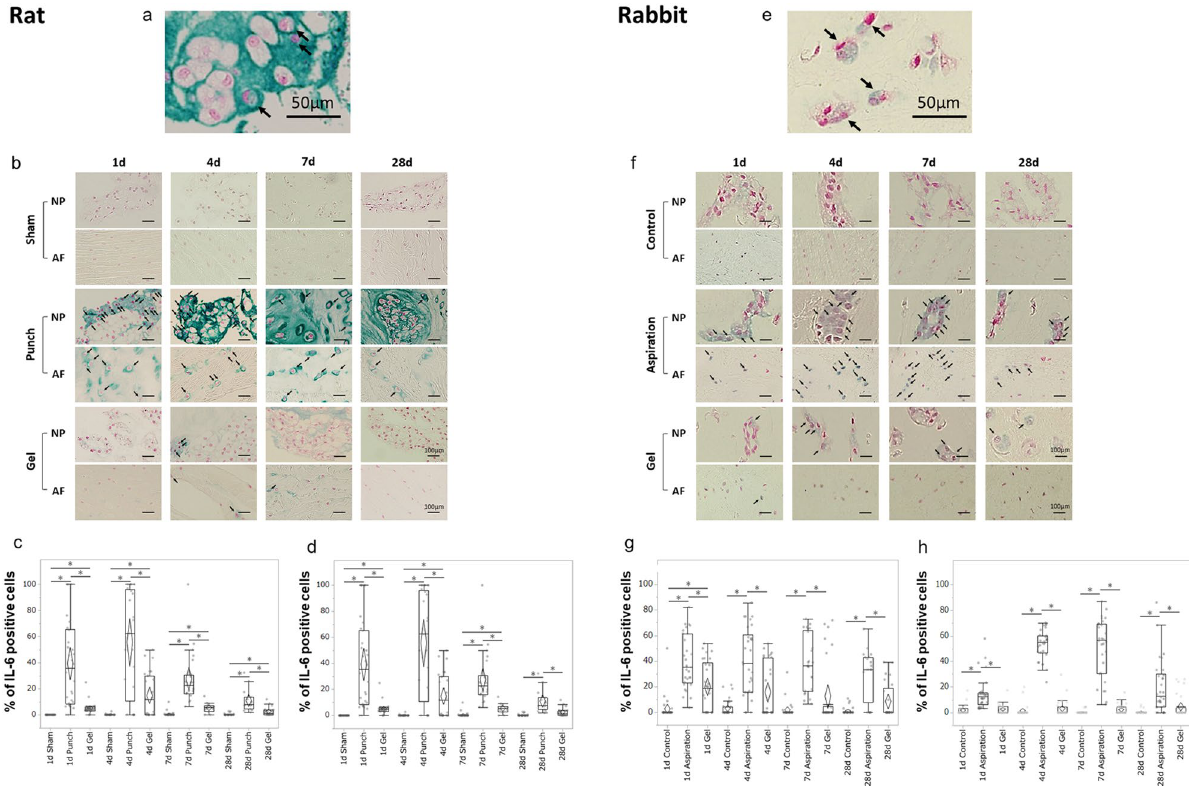
Figure 3. UPAL gel inhibits interleukin-6 (IL-6) production in rat and rabbit intervertebral disc (IVD) degeneration models. The rat nucleus pulposus (NP) punch ( a – d ) and rabbit NP aspiration ( e – h ) models were used for immunohistochemical (IHC) analysis to detect the IL-6 levels 1, 4, 7, and 28 days after surgery. The number of IL-6-positive cells in each staining was calculated as a percentage of the number of total NP or annulus fibrosus (AF) cells in five independent, randomly selected fields per disc. IL-6-positive cells are stained green, and nuclei was stained red. ( a ) Representative image of IL-6-positive NP cells in the rat model (allows). Scale bar, 50 µm. ( b ) Representative IHC staining for IL-6 1, 4, 7, and 28 days after surgery in rat NP and AF tissues. Arrows indicate IL-6-positive cells. Scale bar, 100 µm. Percentage of IL-6-positive cells in rat NP tissue ( c ) and AF tissue ( d ). ( e ) Representative image of IL-6-positive NP cells in the rabbit model (arrows). Scale bar, 50 µm. ( f ) Representative IHC staining for IL-6 1, 4, 7, and 28 days after surgery in the rabbit NP and AF tissues. Arrows indicate IL-6-positive cells. Scale bar, 100 µm. Percentage of IL-6 positive cells in rabbit NP tissue ( g ) and AF tissue ( h ). The percentages of IL-6-positive NP and AF cells in the gel group were significantly lower than those in the punch group or aspiration at each time point in the rat or rabbit model, respectively (* P < 0.05). The boxes represent the median and the interquartile range, with the vertical lines showing the range. The rhombus shape represents the 95% confidence interval (at each time point, n = 3 rats; n = 6 IVDs in each 4 and 7 (sham vs. gel, P = 0.02 on day 4, P < 0.01 on day 7, Fig. 2c). The percentages of TNF-α-positive AF cells in the gel group were significantly higher than those of sham group at postoperative days 4, 7, and 28 (sham vs. gel, P < 0.01 on day 4 and 7, P = 0.01 on day 28, Fig. 2d). In the rabbit model, the percentages of TNF-α-positive NP and AF cells in the gel group were significantly lower than those in the aspiration group at each time point (aspiration vs. gel, P < 0.01 at each time point, Fig. 2f–h). In the gel group, the percentages of TNF-α-positive NP and AF cells were significantly higher than those in the control group at each time point (control vs. gel, P < 0.01 at each time point, Fig. 2g,h), except for the percentages of AF cell on day 1. Regarding the percentages of IL-6-positive NP and AF cells in the punch and gel group in the rat model, the percentages of IL-6-positive NP cells decreased from days 4 to 28 and the percentages of IL-6-positive AF cells decreased from days 7 to 28 (Fig. 3b–d). However, the percentages of IL-6-positive NP and AF cells in the gel group were significantly lower than those in the punch group at each time point (punch vs. gel, NP cells; P < 0.01 on day 1, 7, 28, P = 0.046 on day 4, AF cells; P < 0.01 on day 1, 4, 28, P = 0.01 on day 7, Fig. 3c,d). The percentages of IL-6-positive NP and AF cells in the gel group were significantly higher than those of sham group (sham vs. gel, P < 0.01 at each time point except for the percentages of NP cells on day 28, NP cells; P = 0.02 on day 28, Fig. 3c,d). In rabbits, the postoperative changes in the percentages of IL-6-positive NP and AF cells were similar to those in rats (Fig. 3f), and the percentages of IL-6-positive NP and AF cells in the gel group were significantly lower than those in the aspiration group at each time point (aspirate vs. gel, NP cells; P = 0.04 on day 1, P < 0.01 on day 4 and 7, P = 0.01 on day 28, AF cells; P < 0.01 at each time point, Fig. 3g,h). In the gel group, the percent- ages of IL-6-positive NP and AF cells were not significantly different between the control and gel groups, except